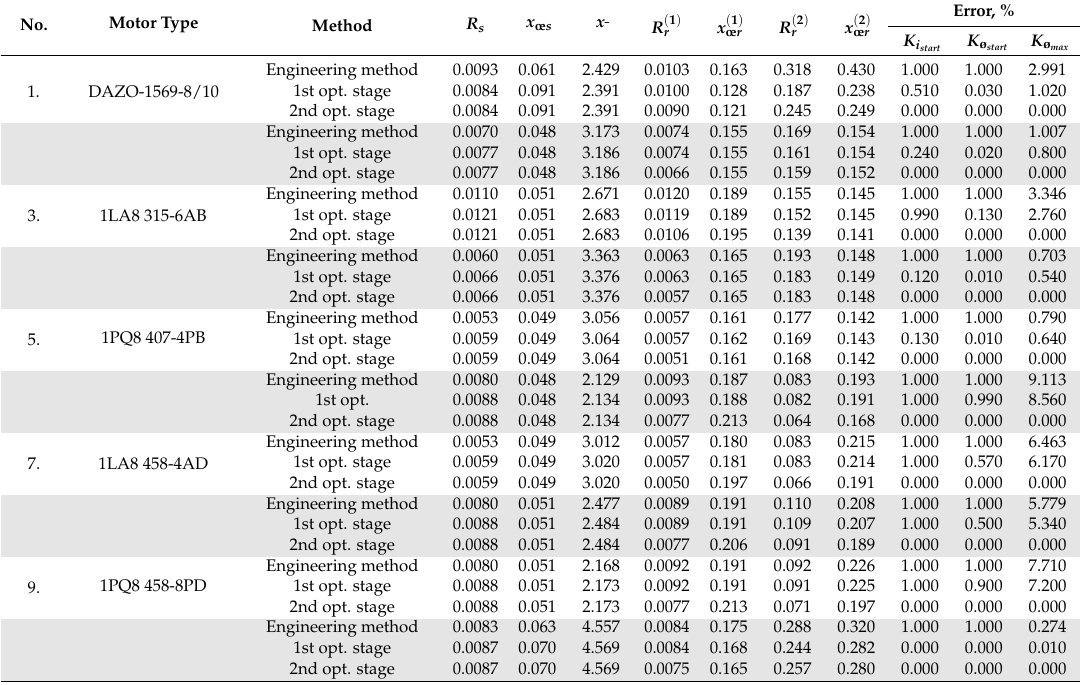
Table 4. Equivalent circuit model parameters determined by the engineering method and the two-stage